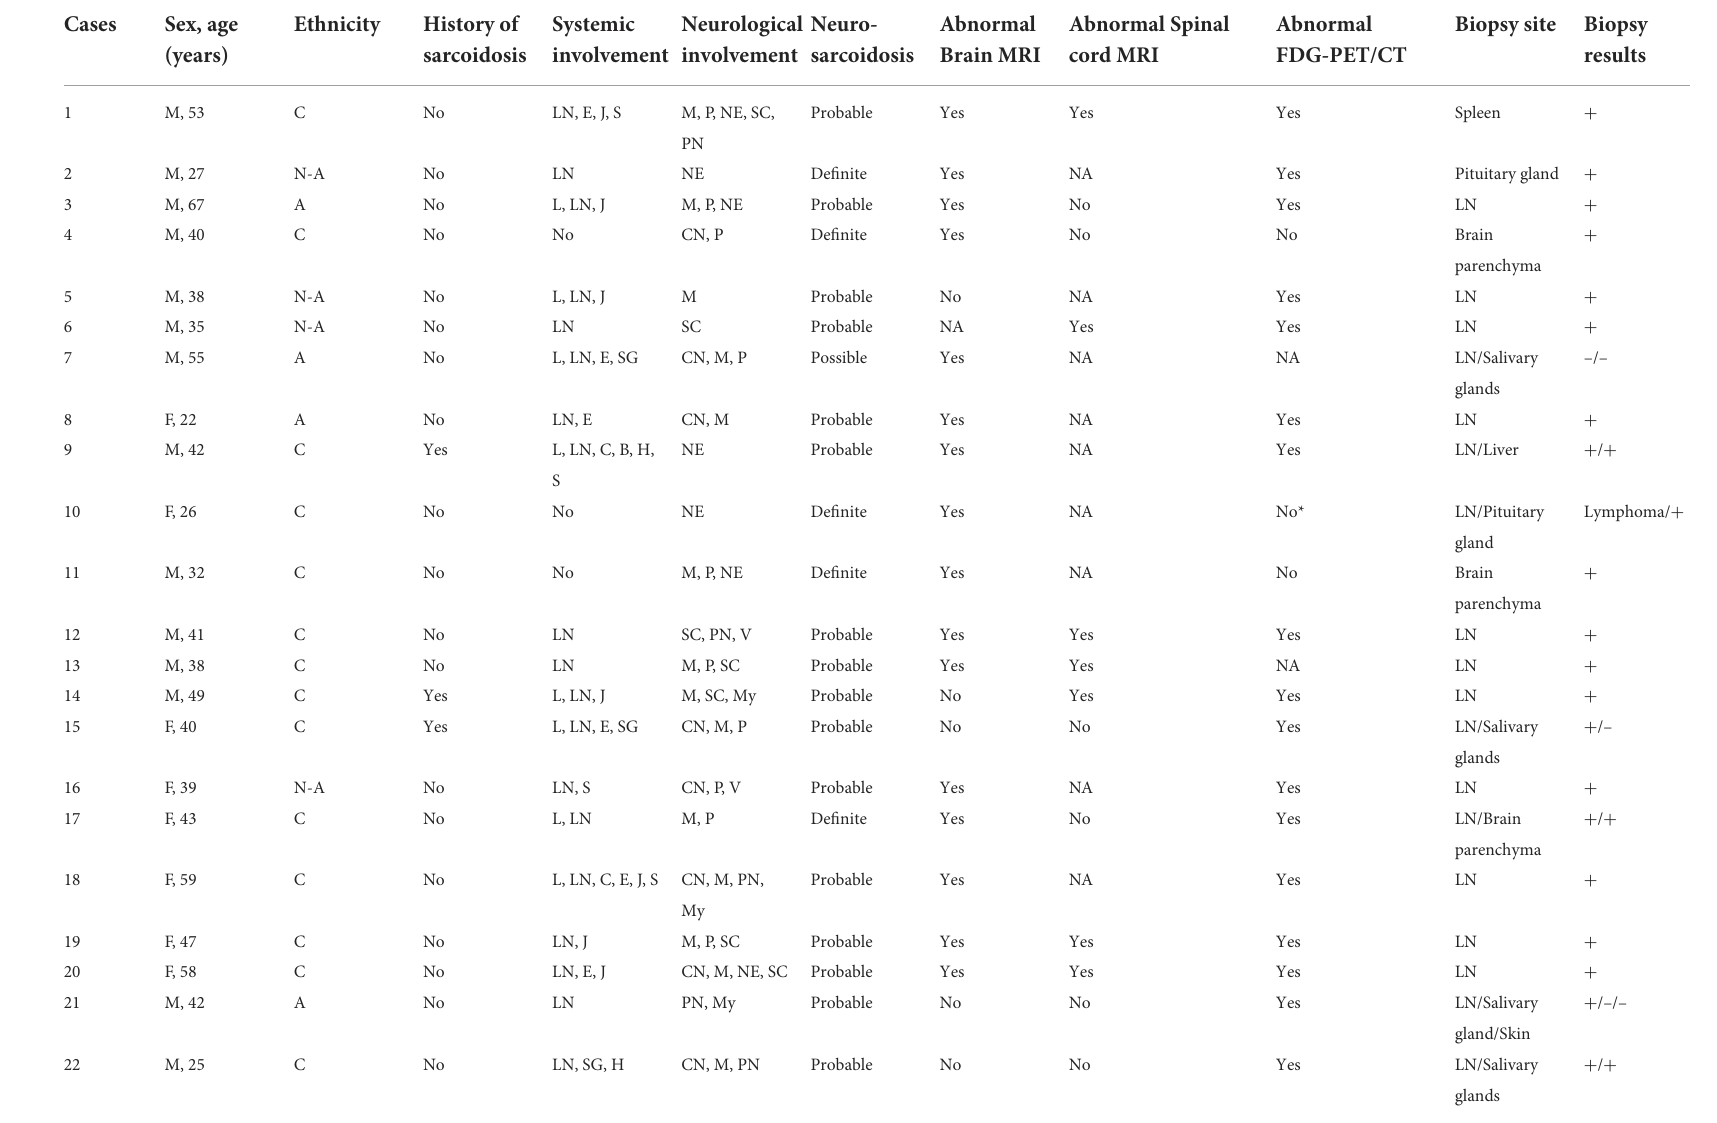
TABLE 1 Baseline characteristics of our patient cohort diagnosed with neurosarcoidosis.